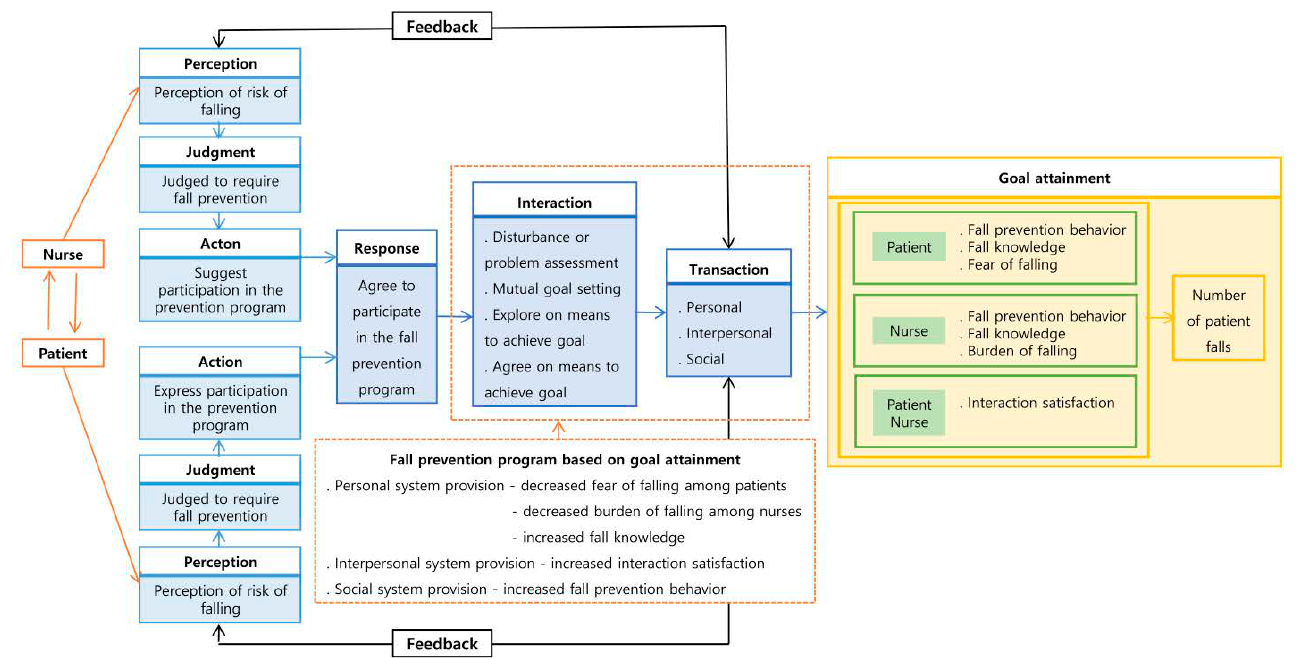
Figure 1. Conceptual framework of a fall prevention program on King’s goal attainment theory.